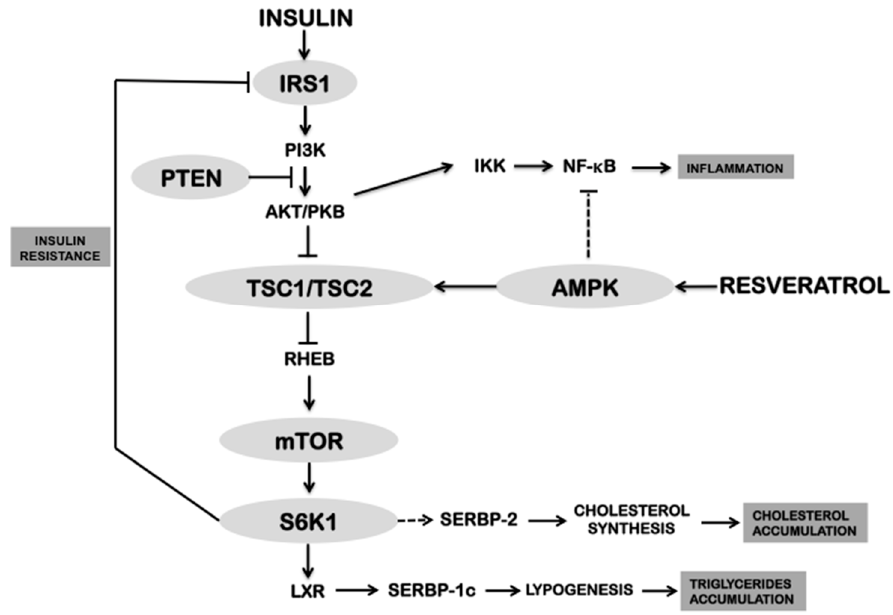
Figure 2. Integration of the physiological effects of resveratrol mediated by activation of AMPK and inhibition of IRS1/PI3K/AKT pathway. AMPK activation by resveratrol causes a pleiotropic effect and inhibits the anabolic pathway IRS1/PI3K/AKT, thus decreasing the accumulation of cholesterol and triglycerides, as well as improving the insulin resistance and inflammatory processes.